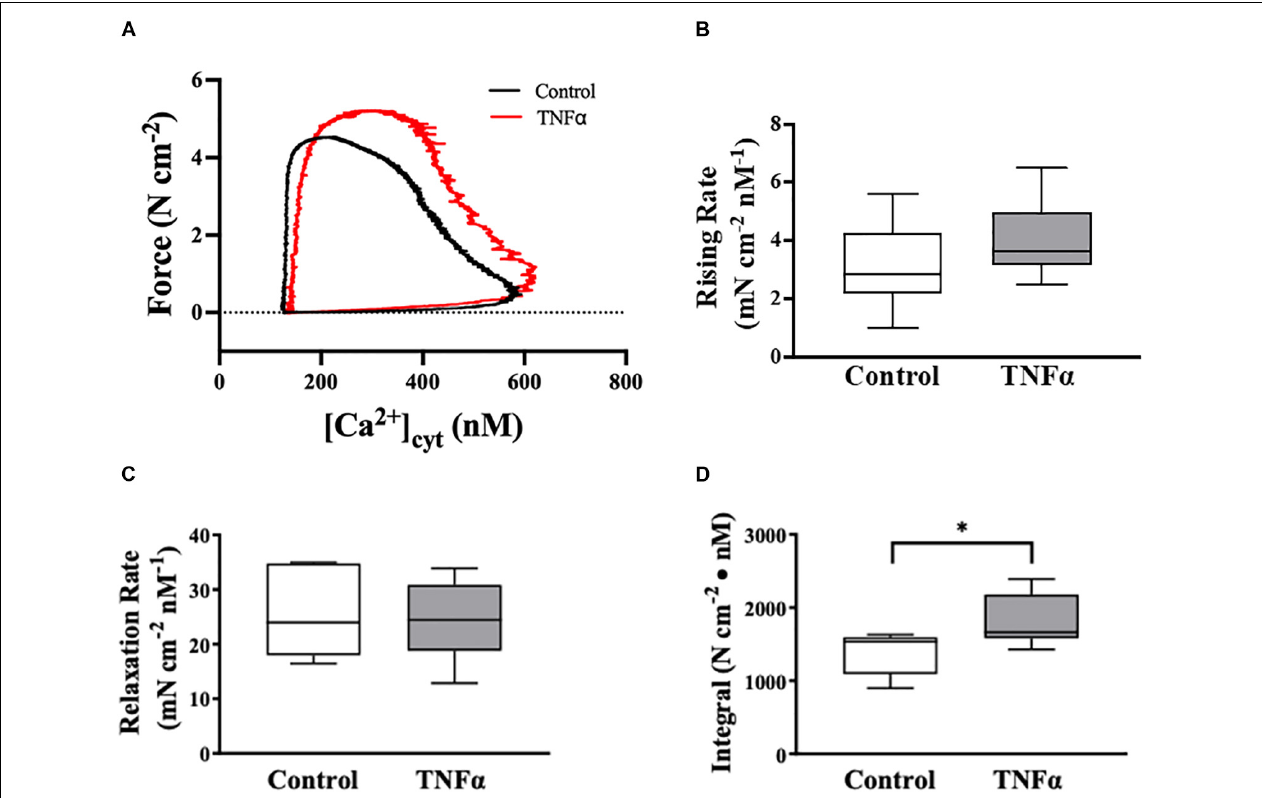
FIGURE 5 | Tumor necrosis factor α significantly increased the integral of the rising phase of the phase-loop plots of ACh-induced [Ca 2 + ] cyt and force as compared to controls. Representative tracings of phase-loop plots at ACh concentration (EC 50 ) are presented in (A) . Both rising rate and relaxation rate of the phase-loop plots in TNF α treated group were not different than untreated controls [ p > 0.05, n = 6 (number of animals)]. (B,C) The integral of the rising phase of the phase-loop plots of ACh-induced [Ca 2 + ] cyt and force was summarized and found to increase significantly with TNF α [ ∗ p < 0.05, n = 6 (number of animals)] (D)